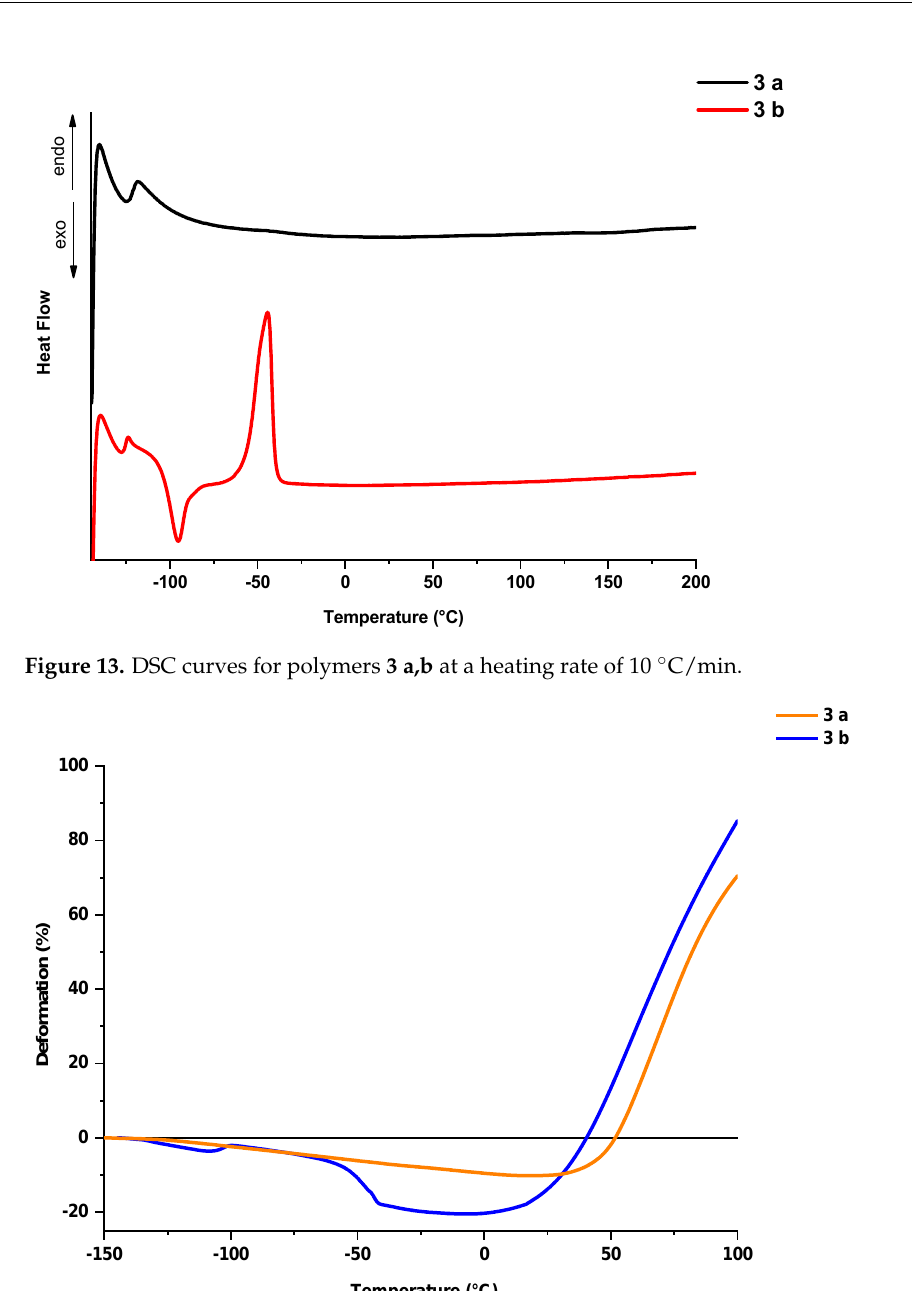
Figure 14. TMA curves for polymers 3 a,b at a heating rate of 5 °C/min in dilatometric mode with a constant load of 0.01 N.